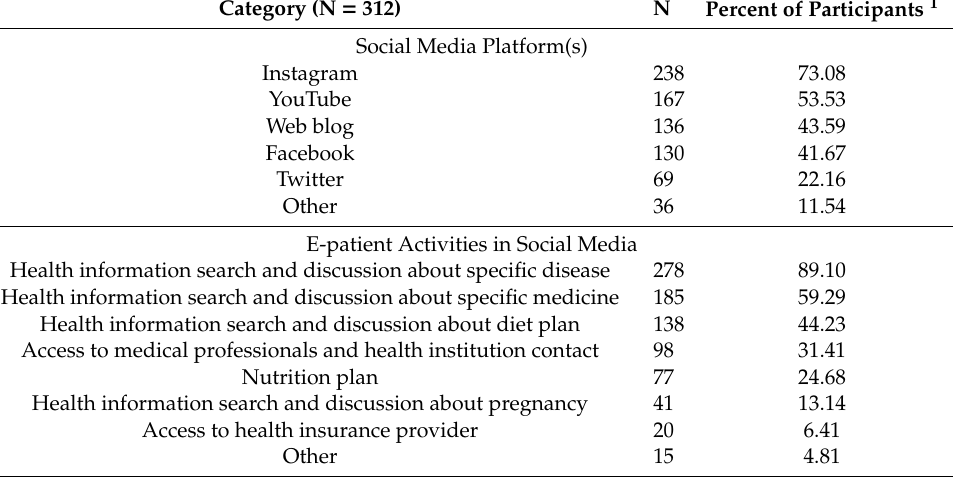
Table 2. Social media platform and type of e-patient